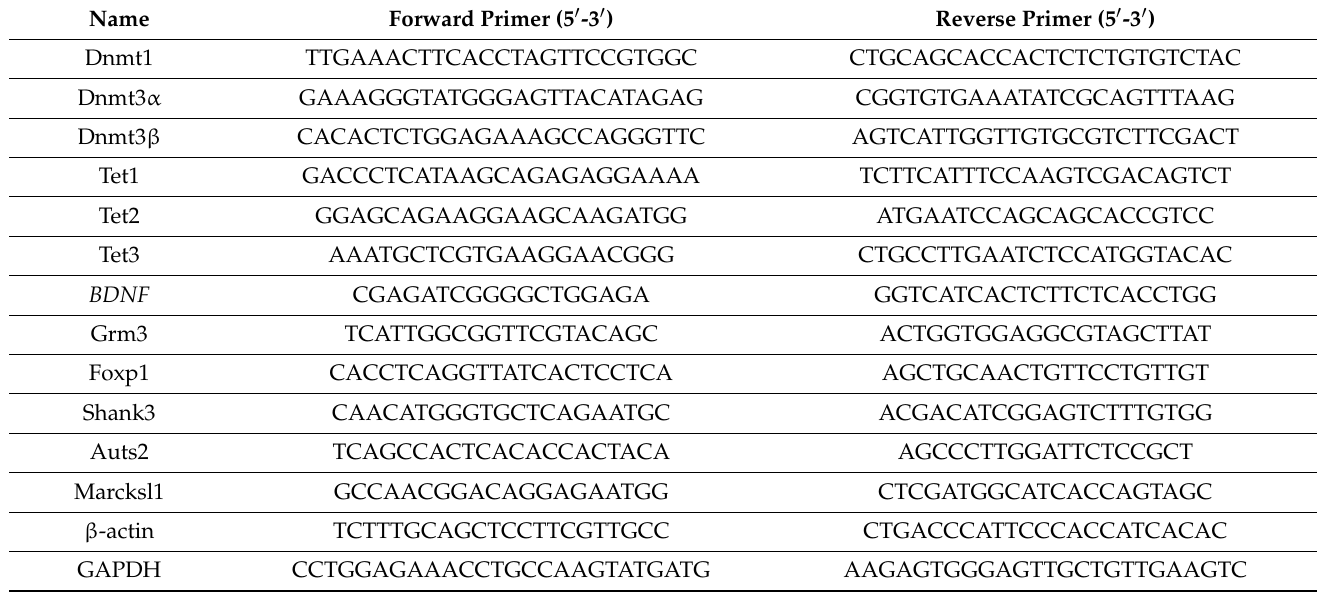
Table 2. Primers used to amplify cDNA following reverse